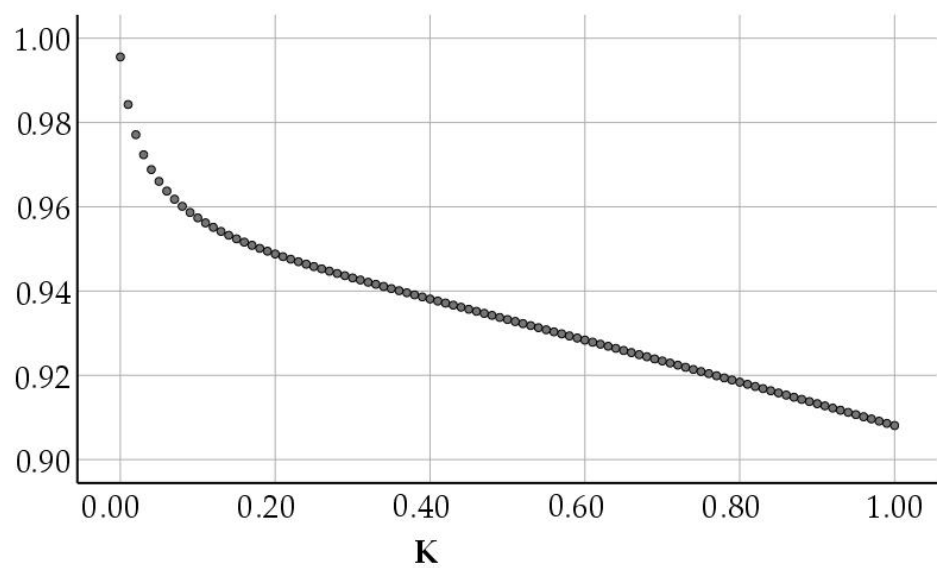
Figure 3. Ridge trace map.